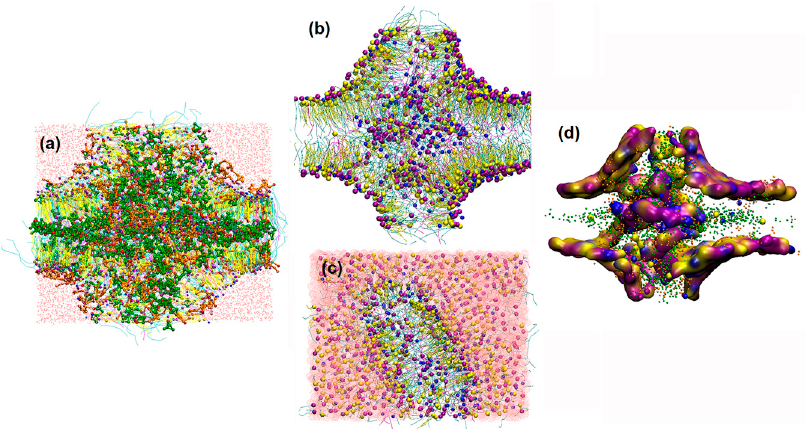
Figure 7. Detail illustration of osthole molecules interacting with water pores and reversed micelles formed by 10% borneol, 10% osthole and SC lipids by CG-MD simulations: ( a ) lateral view of the bilayer with all the constituent molecules; ( b ) lateral and ( c ) vertical views of the bilayer with lipid and solvent molecules; and ( d ) lateral view of the bilayer with hydrophilic head groups shown in density map and hydrophobic alkyl chains hidden.